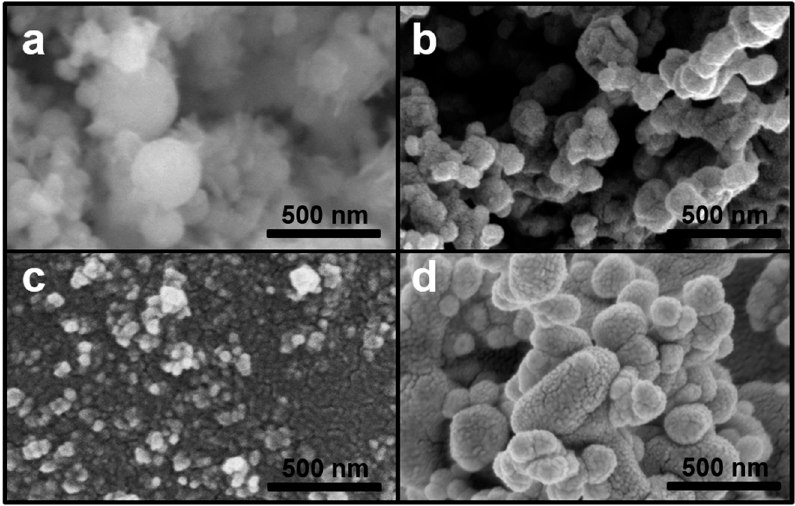
Figure 1. Scanning electron microscope observation of nanoparticles: ( a ) Al, ( b ) Cu, ( c ) Al 2 O 3 , and ( d ) CuO.